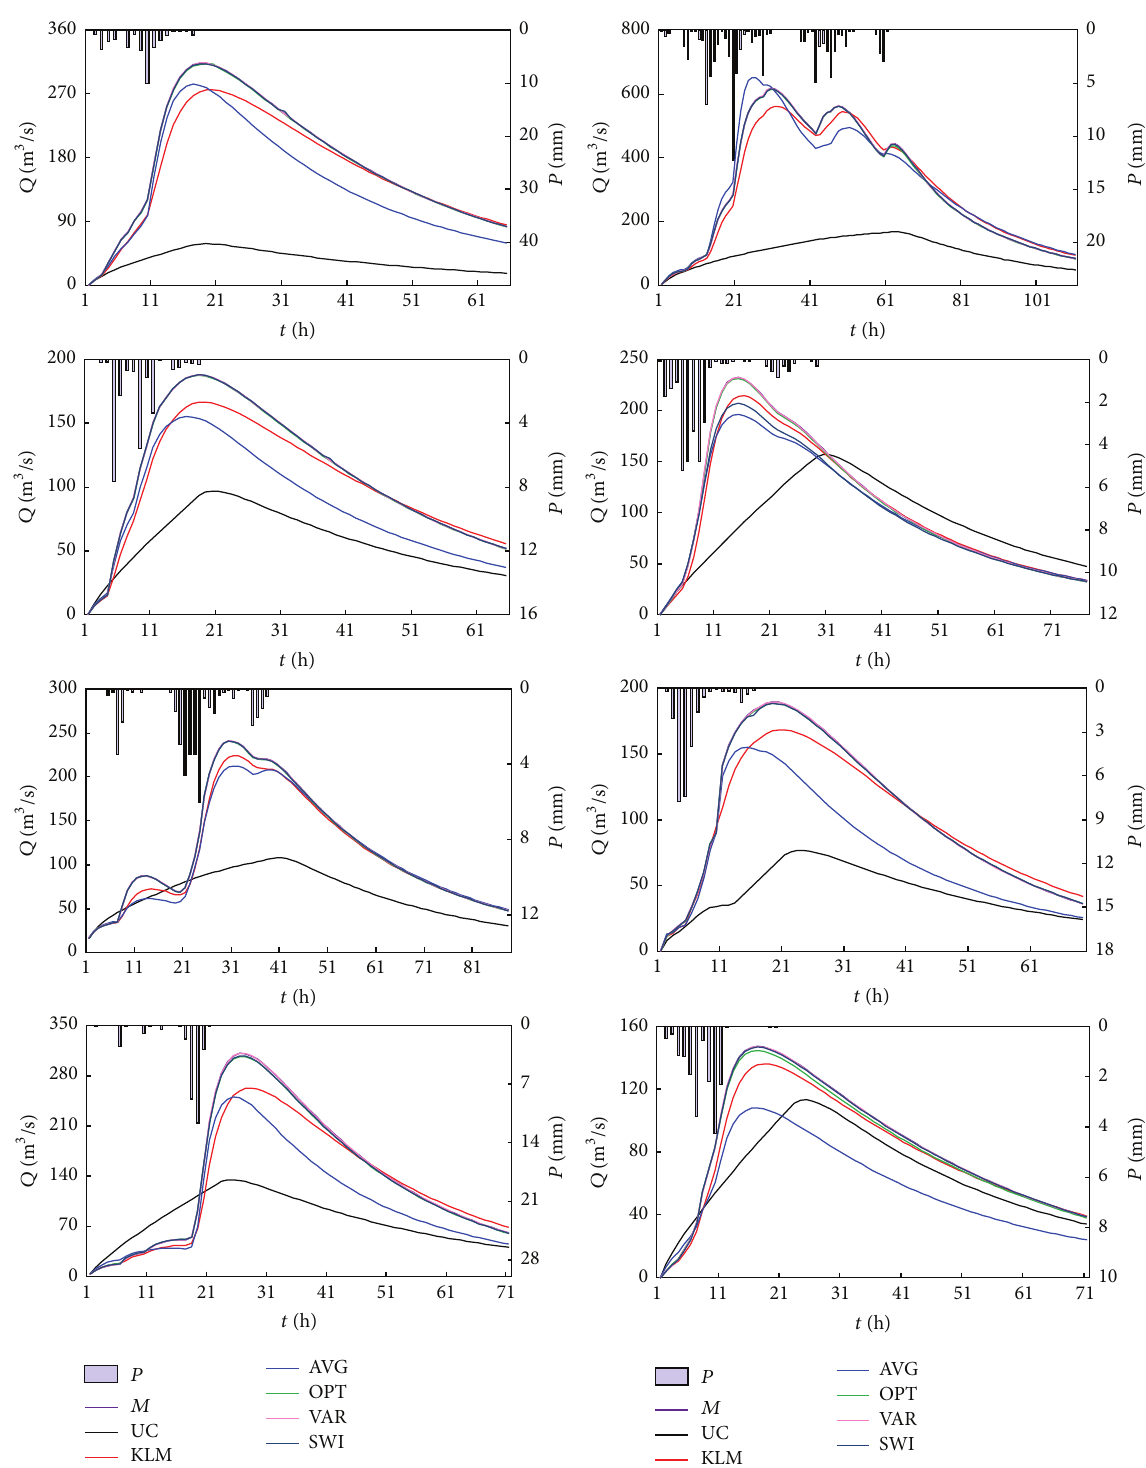
Figure 3: Comparison of simulated hydrographs for eight storm events using rainfall input data derived from five assimilation methods and uncalibrated radar data. 𝑀 is measured